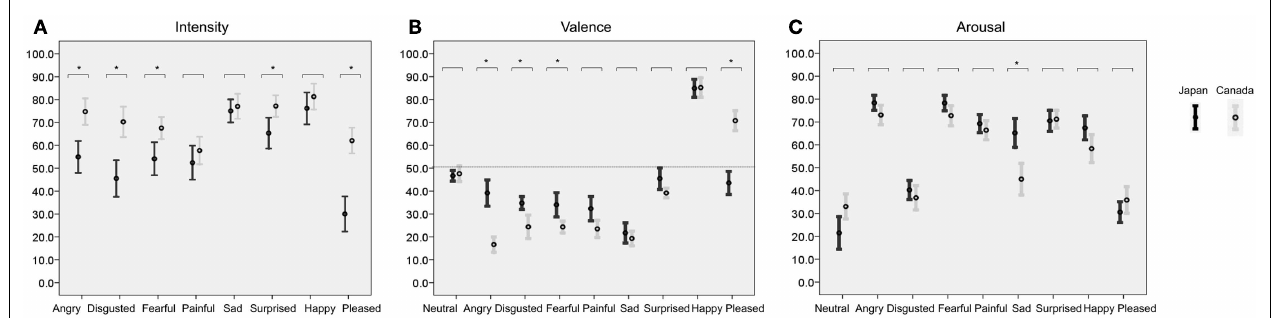
of emotional vocalizations. A mixed two-way ANOVA represents significant main effects of Subject group (Japanese and Canadian) and Emotion, respectively: p < 0.001; * p < 0.05/8 (Intensity), * p < 0.05/9 (Valence), * p < 0.05/9 (Arousal); post hoc t